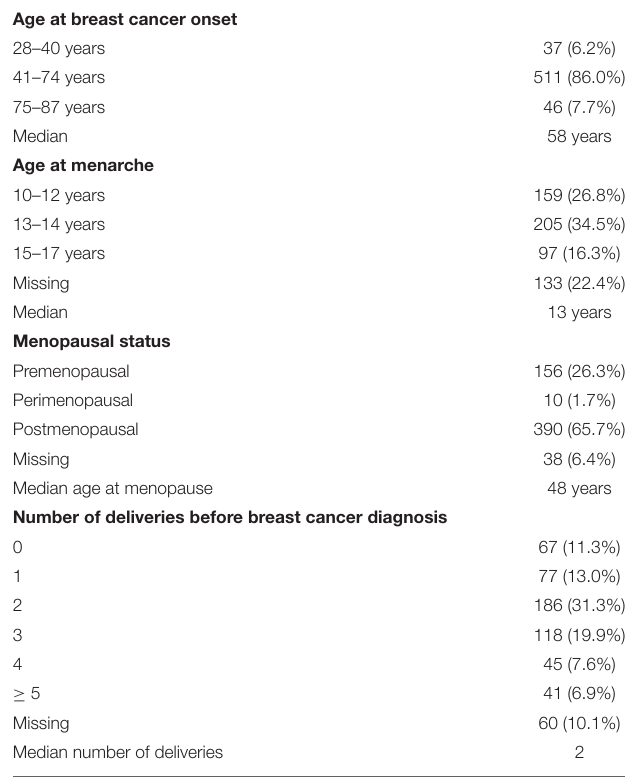
TABLE 1 | The distribution of patient